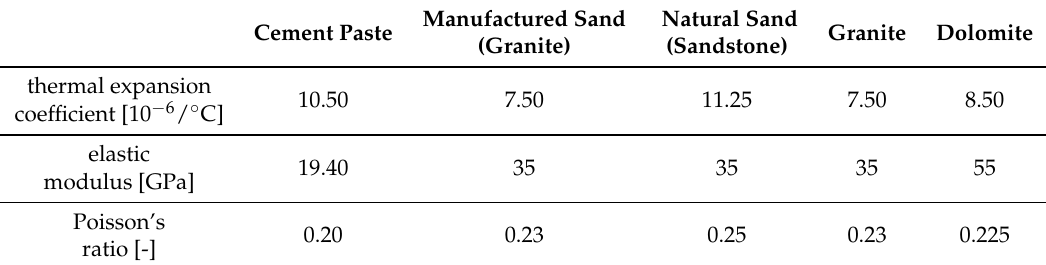
Table 5. Input for model predictions of the experiments by Tasneem et al. [3]: thermal expansion coefficients and elastic parameters of the cement paste, the fine aggregates and the coarse aggregates.